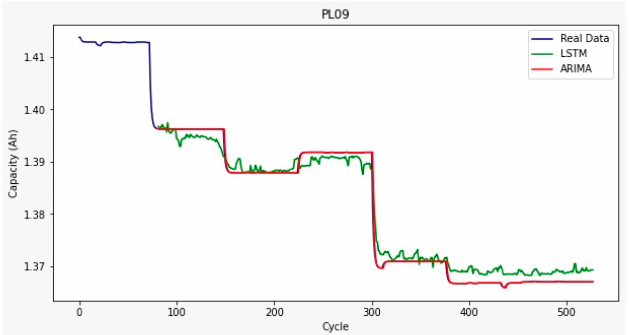
Figure 16. Train, test, and predicted data results from ARIMA and LSTM models for